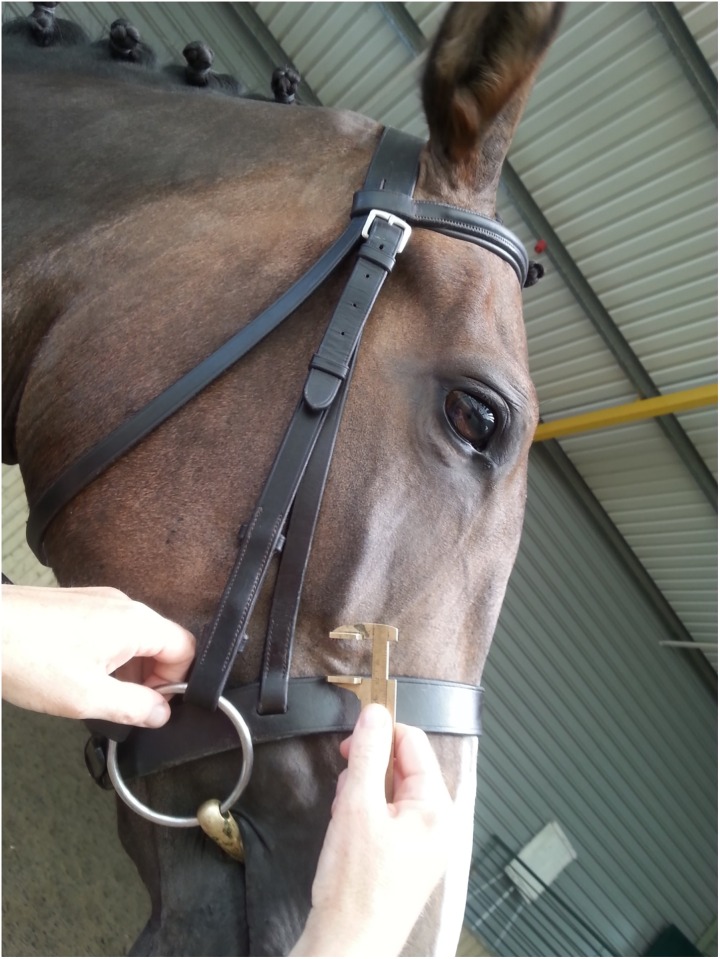
Use of TB callipers to measure distance (mm) between rostral margin of facial crest and caudal margin of noseband.